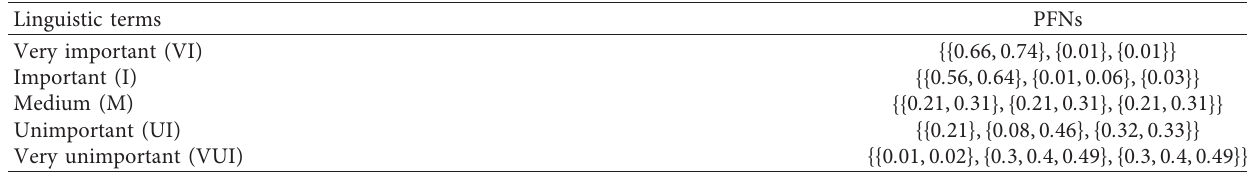
Table 1: Importance weights as linguistic variables.